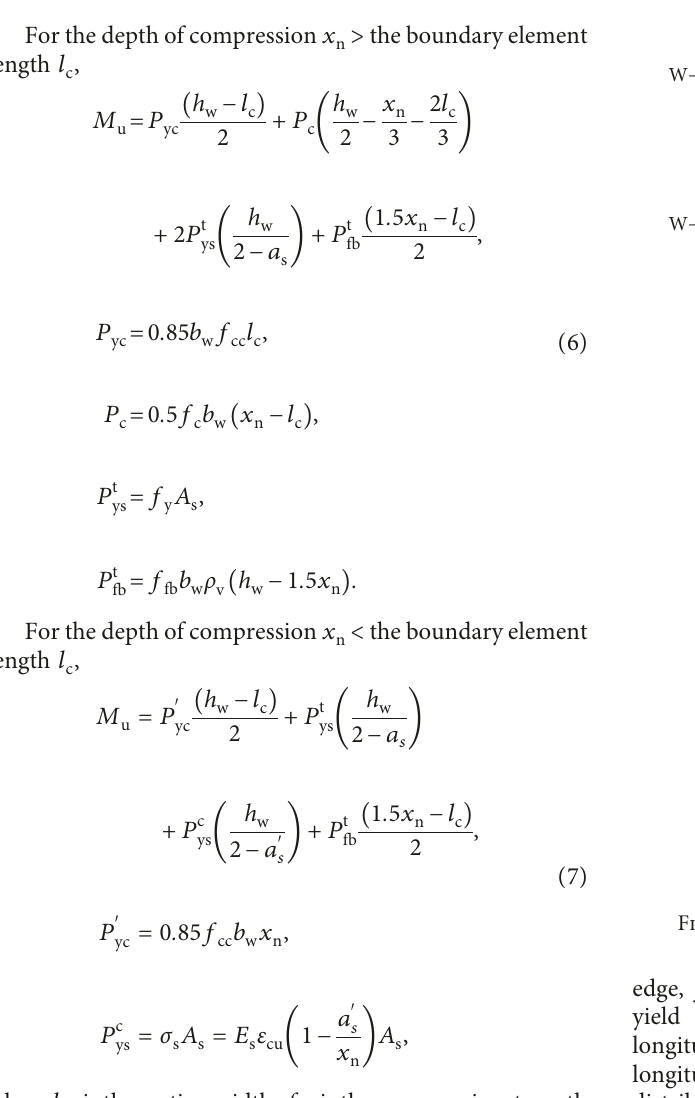
Figure 28: CSMAXSCR-top displacement curves of W3 under 0.5 axial compression ratio.